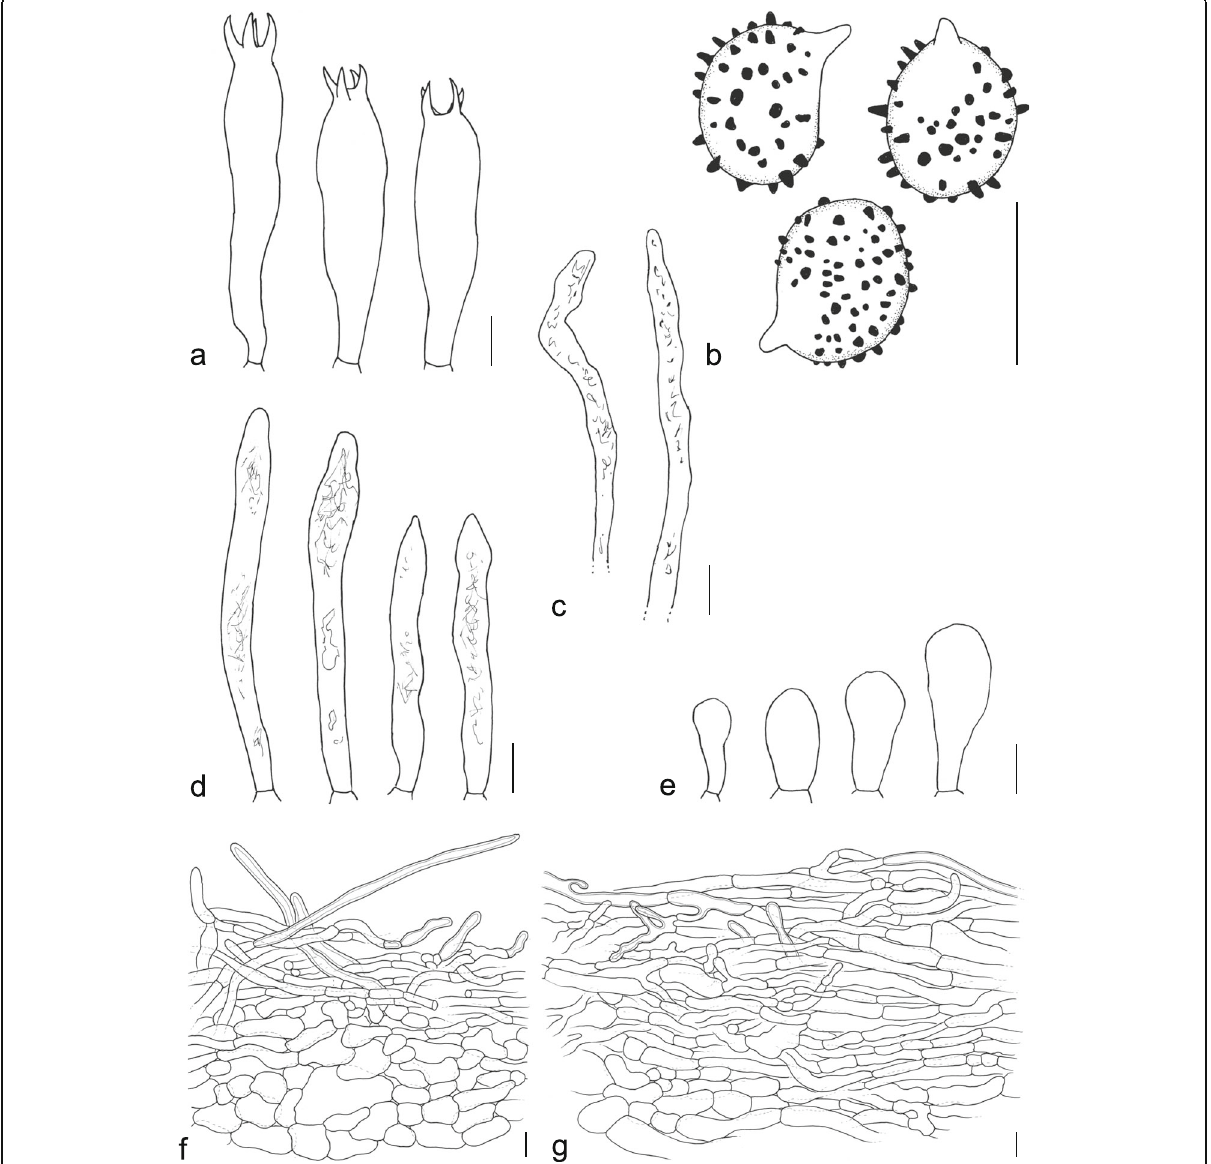
Fig. 4 Lactifluus hallingii (AEF 555, AEF 756, FH 18 – 077, REH 7993). a Basidia. b Basidiospores. c Pseudocystidia. d Macrocystidia. e Marginal cells. f Section through the stipitipellis. g Section through the pileipellis. Bars = 10 μ